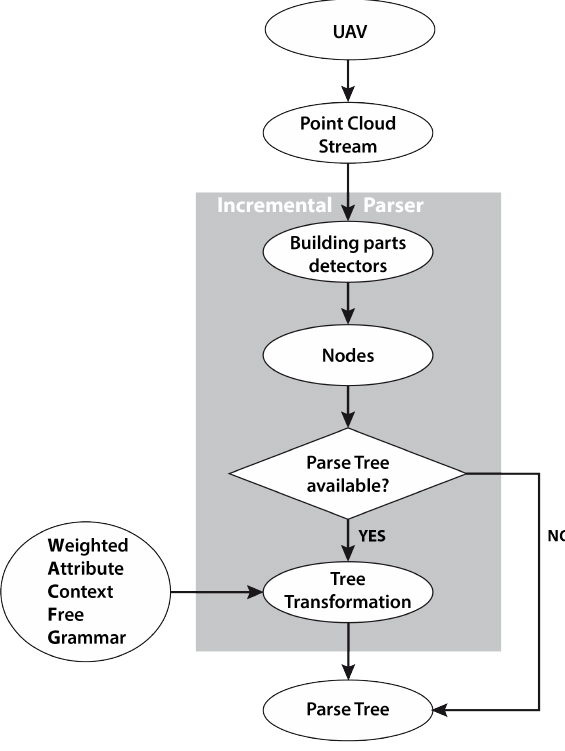
Figure 3: An overview of the incremental attribute grammar pars- ing of a 3D point cloud